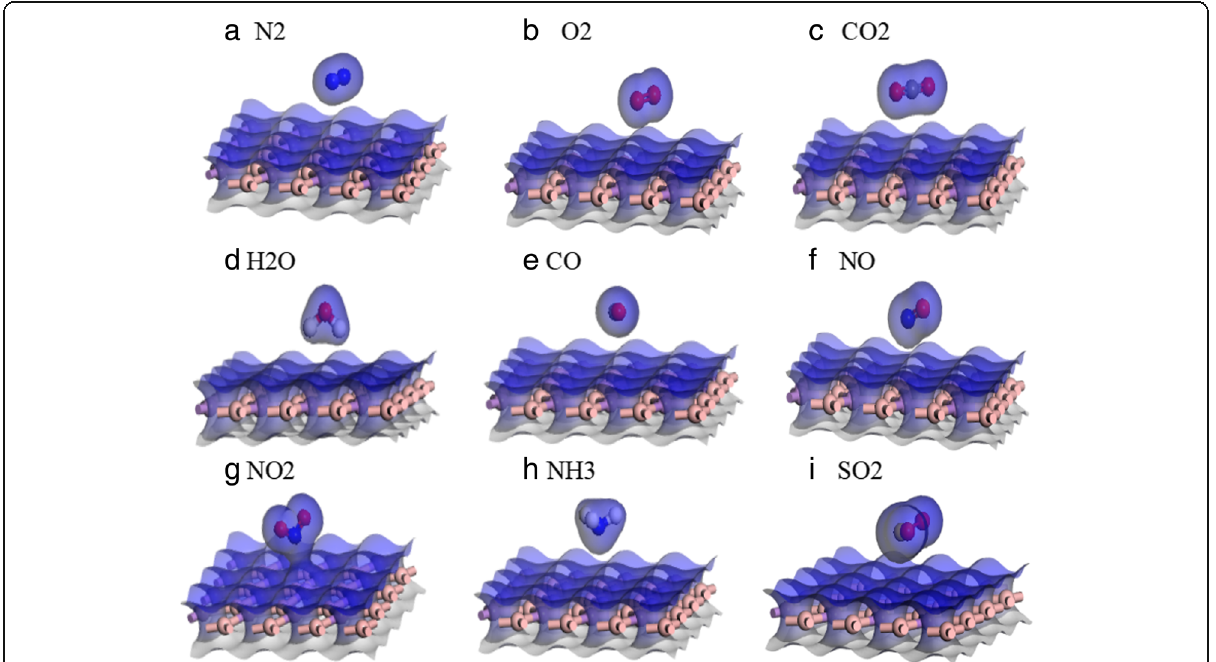
Fig. 4 Electron density for pristine N 2 /BAs ( a ), O 2 /BAs ( b ), CO 2 /BAs ( c ), H 2 O/BAs ( d ), CO/BAs ( e ), NO/BAs ( f ), NO 2 /BAs ( g ), NH 3 /BAs ( h ), and